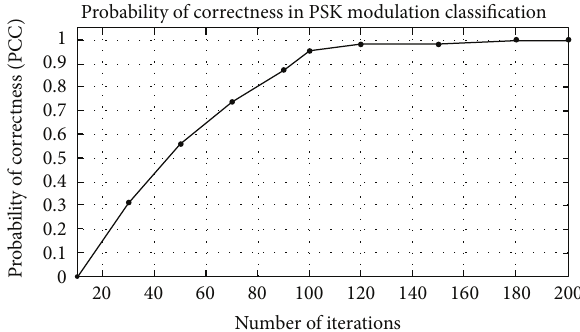
Figure 10: Probability of correctness (PCC) versus number of iterations at SNR = 10dB for PSK4